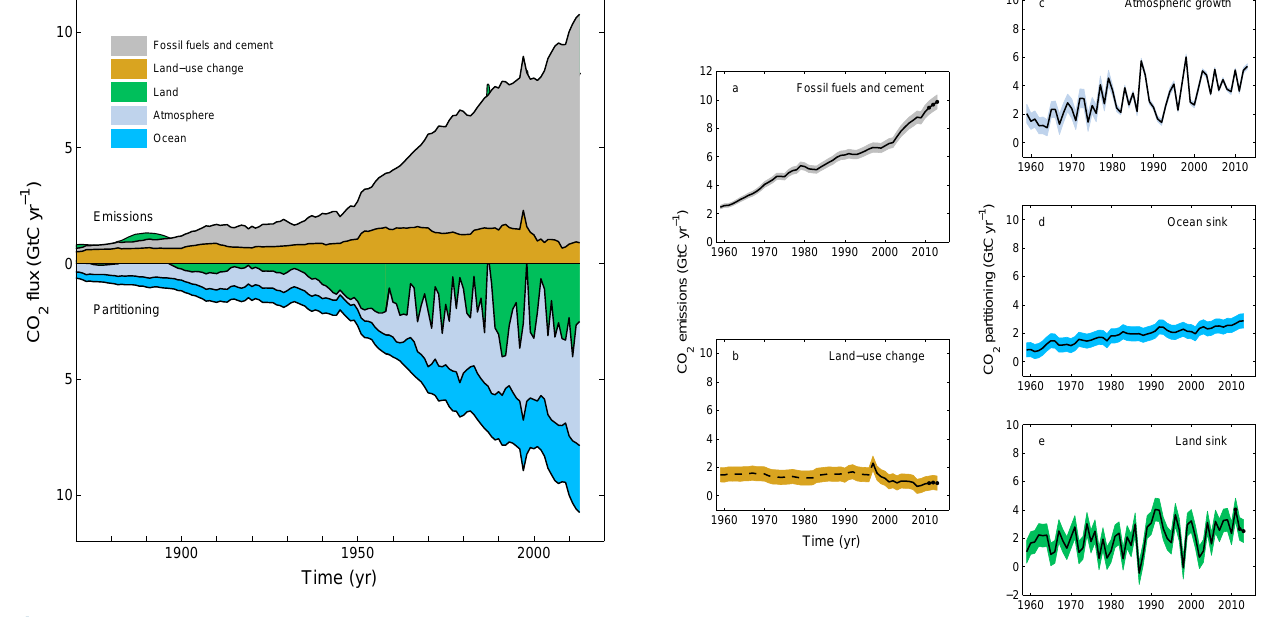
Figure 3. Combined components of the global carbon budget il- lustrated in Fig. 2 as a function of time for emissions from fossil fuel combustion and cement production ( E FF ; grey) and emissions from land-use change ( E LUC ; brown), as well as their partitioning among the atmosphere ( G ATM ; light blue), land ( S LAND ; green), and oceans ( S OCEAN ; dark blue). All time series are in GtCyr − 1 . G ATM and S OCEAN (and by construction also S LAND ) prior to 1959 are based on different methods. The primary data sources for fossil fuel and cement emissions are from Boden et al. (2013), with uncertainty of about ± 5% ( ± 1 σ ); land-use-change emis- sions are from Houghton et al. (2012) with uncertainties of about ± 30%; the atmospheric growth rate prior to 1959 is from Joos and Spahni (2008) with uncertainties of about ± 1–1.5GtCdecade − 1 or ± 0.1–0.15GtCyr − 1 (Bruno and Joos, 1997), and from Dlu- gokencky and Tans (2014) from 1959 with uncertainties of about ± 0.2GtCyr − 1 ; the ocean sink prior to 1959 is from Khatiwala et al. (2013) with uncertainty of about ± 30%, and from this study from 1959 with uncertainties of about ± 0.5GtCyr − 1 ; and the resid- ual land sink is obtained by difference (Eq. 8), resulting in uncer- tainties of about ± 50% prior to 1959 and ± 0.8GtCyr − 1 after that. See the text for more details of each component and their uncertain- ties.